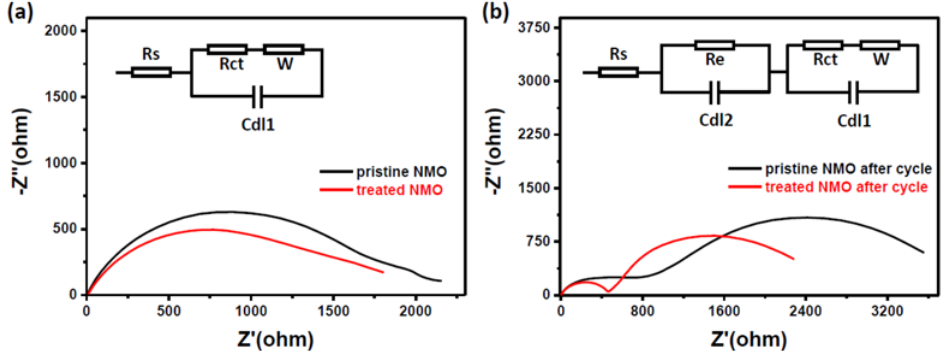
Figure 4. Electrochemical impedance spectroscopy (EIS) before ( a ) and after ( b ) charge and discharge, after assembly of pristine NMO and treated NMO into a battery.